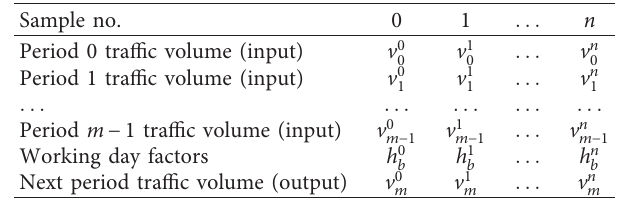
Table 3: Format of traffic flow forecast training data for m period before the